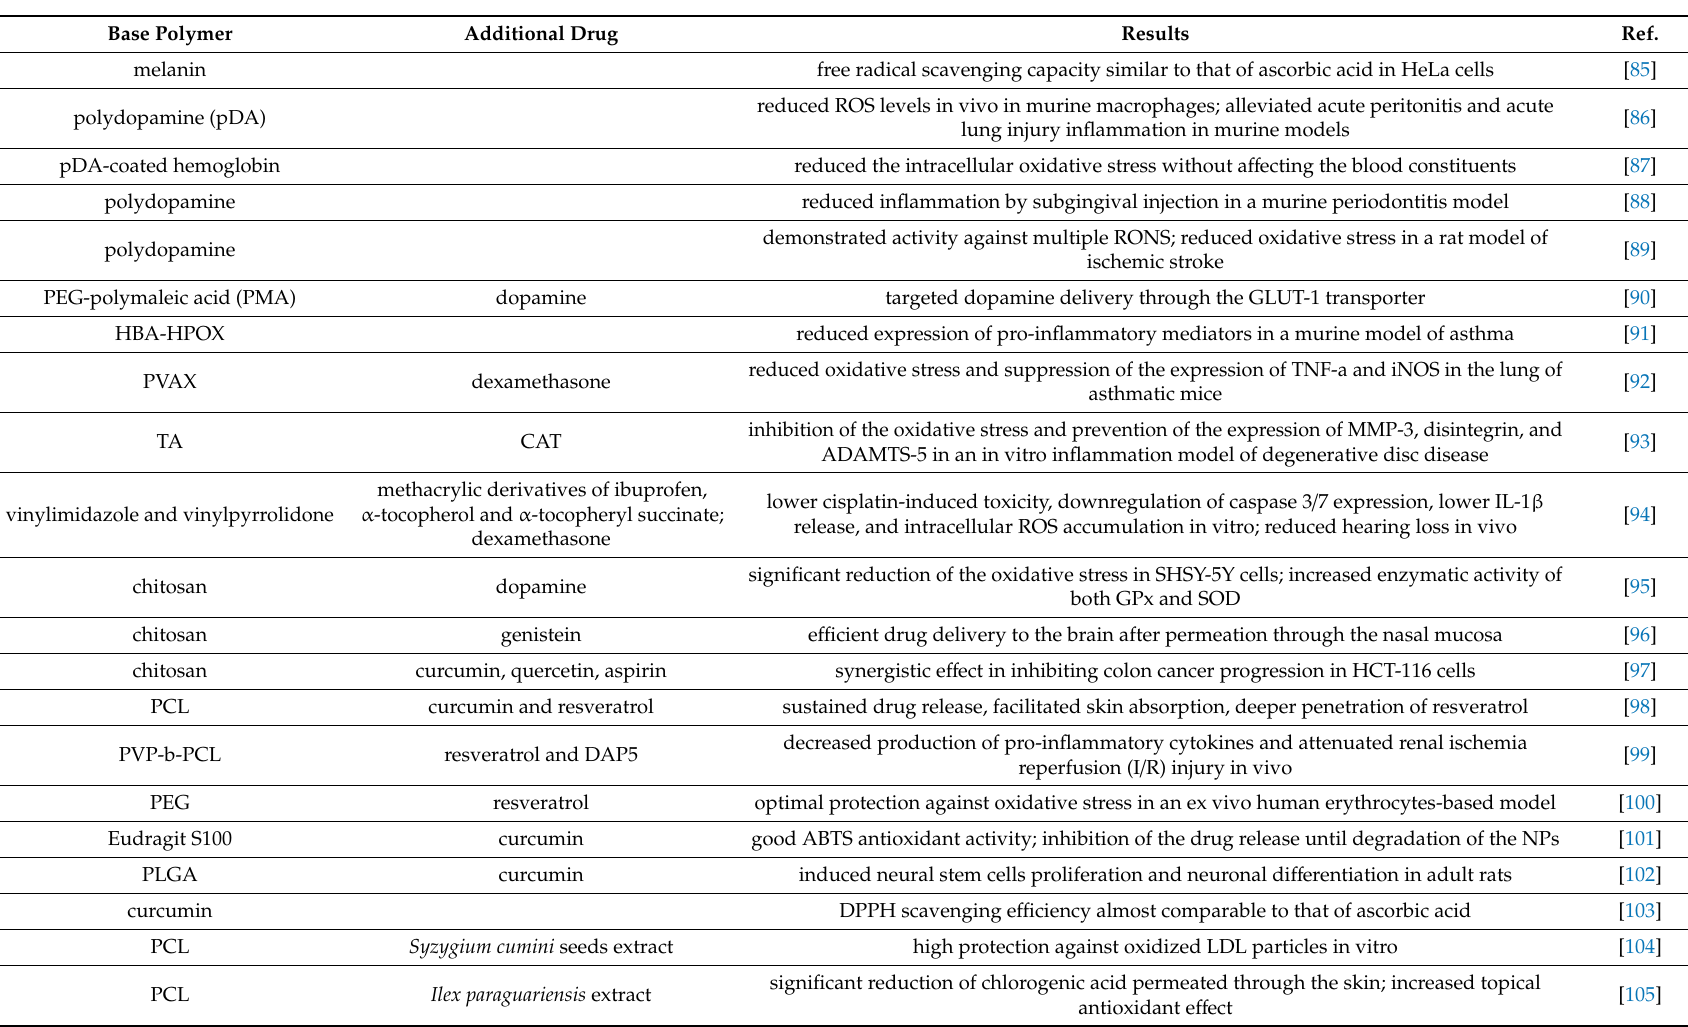
Table 4. Summary of the polymeric antioxidant NPs and their e ff ects. RONS: reactive oxygen and nitrogen